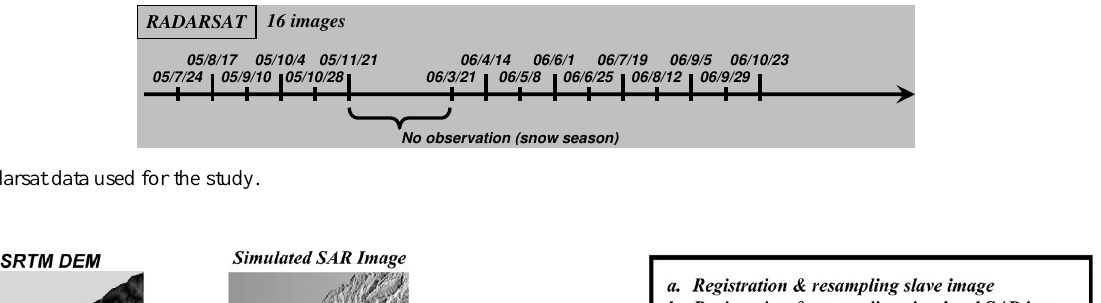
(a) capable of phase unwrapping, (b) coherence values greater than